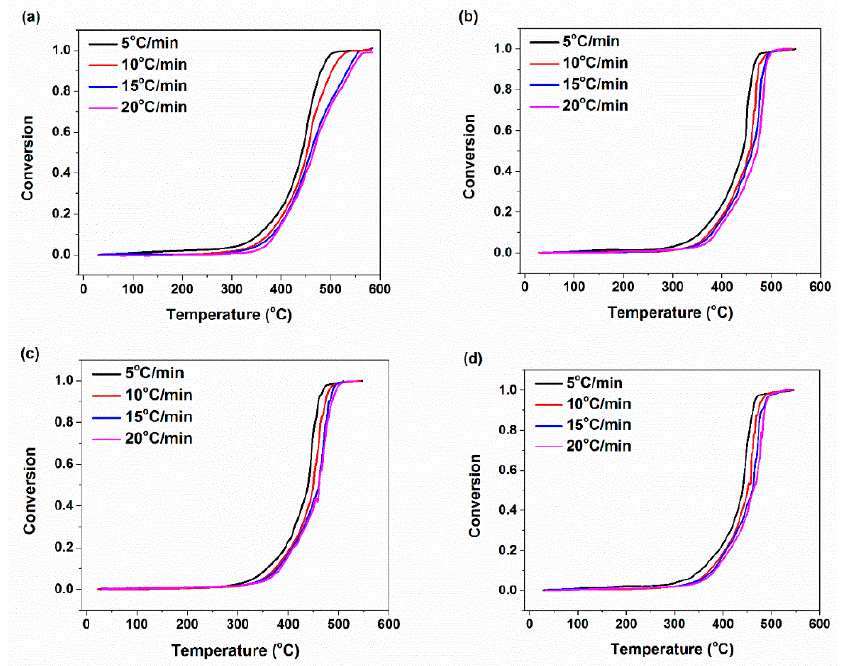
Figure 12. Degradation conversion plots of XNBR/epoxy/XHNT nanocomposites at various heating rates ( a ) XE15 ( b ) XE15H3 ( c ) XE15H5 ( d ) XE15H7.